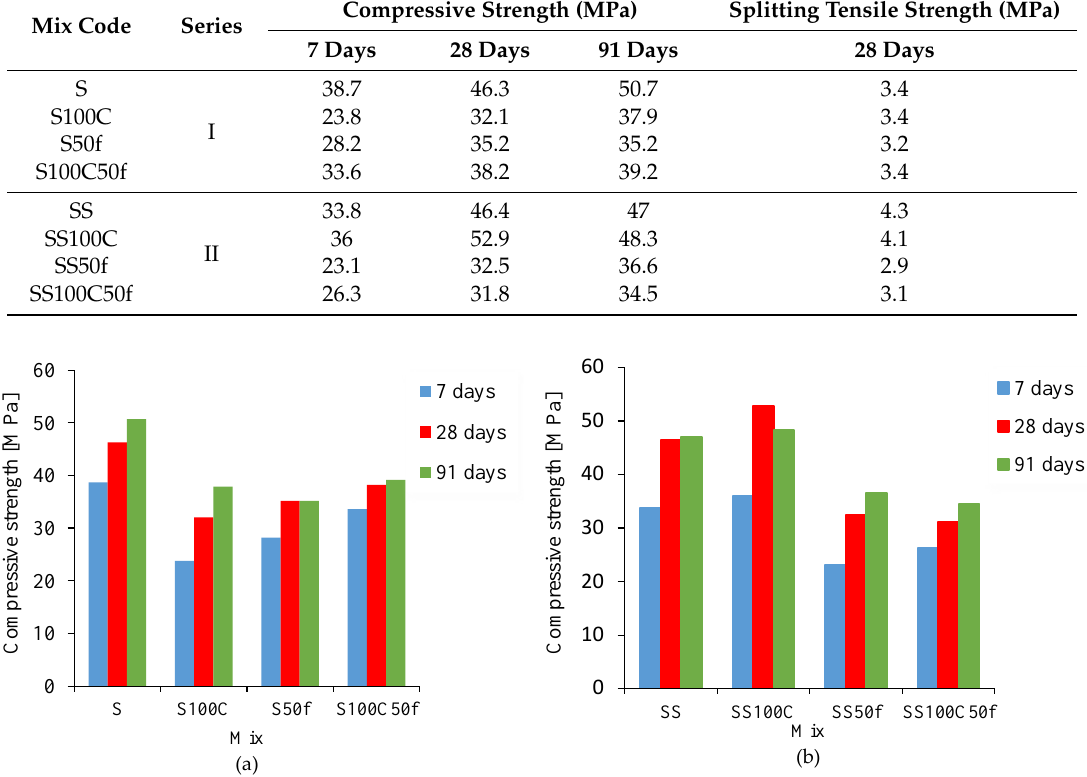
Figure 8. Compressive strength results at 7, 28, and 91 days of ( a ) Series I and ( b ) Series II.